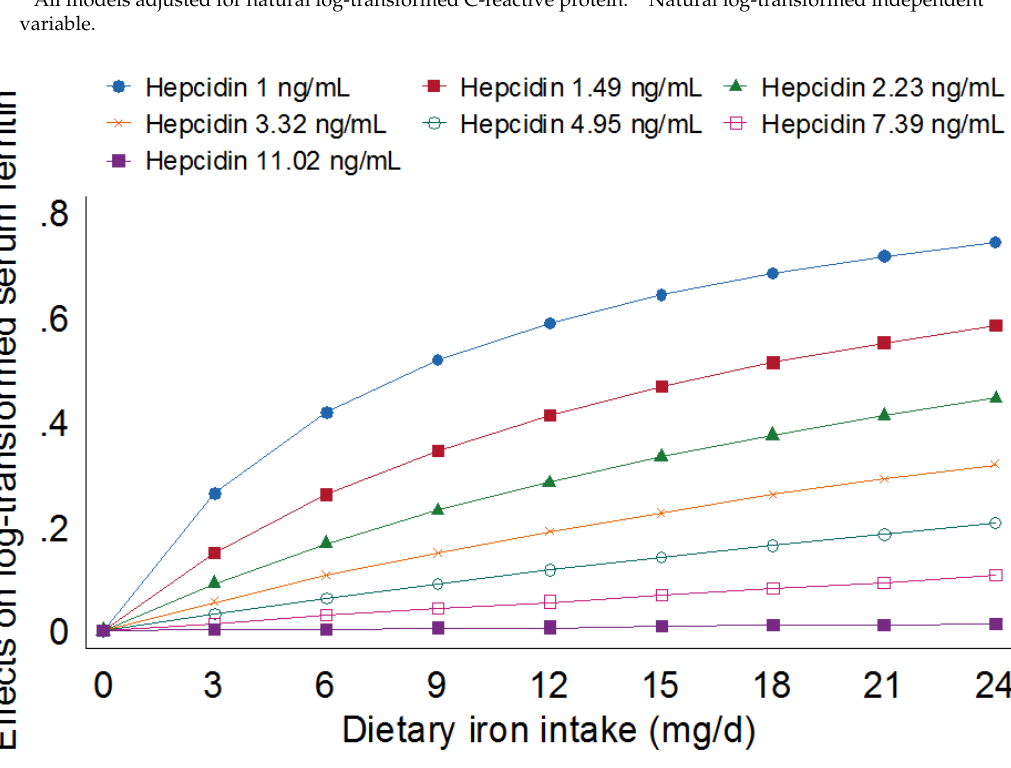
Figure 2. Effect of serum hepcidin on the relationship between dietary iron intake and natural log-transformed serum ferritin concentration, holding CRP, blood donation and menstrual losses at their mean values (CRP 0.67 mg/L, blood donation 400 mL/year, menstrual loss 104 arbitrary units, blood sampling at 11:15). The association between dietary iron intake and natural log-transformed serum ferritin is non-significant at 7.39 and 11.02 ng/mL (hepcidin concentrations > 11.02 ng/mL not